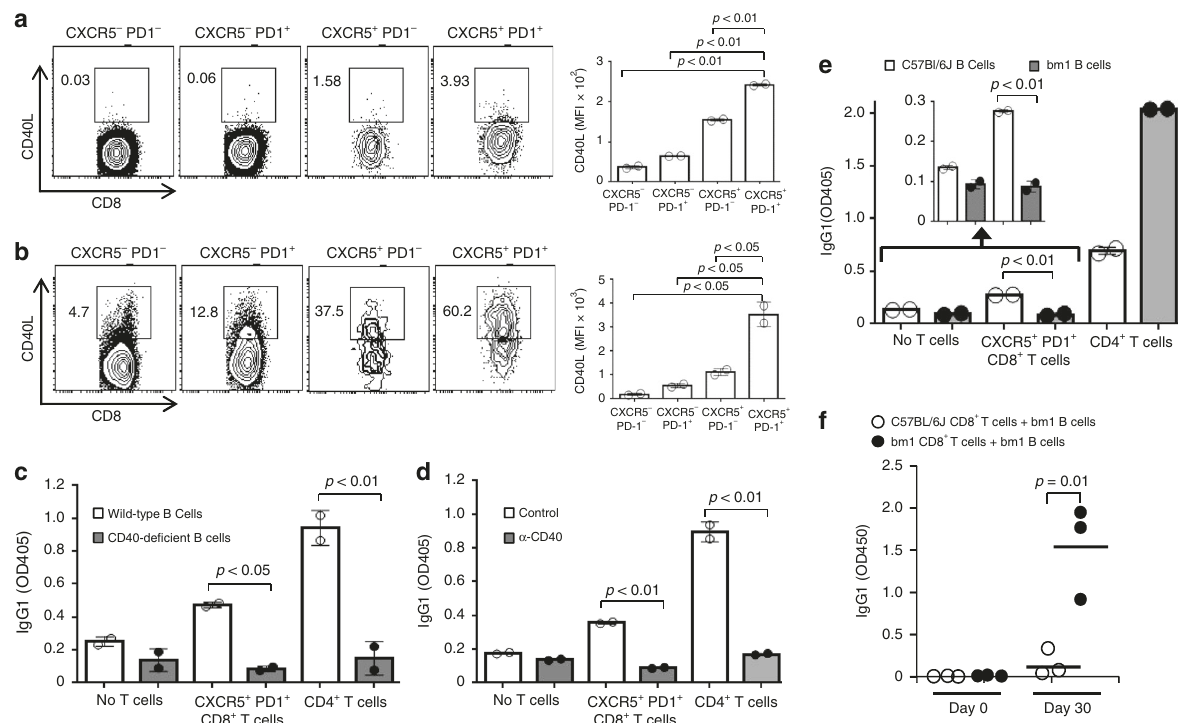
Fig. 7 CD40L/CD40 and TCR/MHC I interactions required for CD8 + Tfh function. a CD40L expression in CXCR5 + PD-1 + CD8 + T cells. Splenocytes from LCMV-infected wild-type mice were stained with anti-CD4, anti-CD8, anti-CXCR5, anti-PD-1 and anti-CD40L antibodies. Numbers indicate percentages of CD40L + cells (left) and bar graphs show the average MFI of CD40L expression in the indicated CD8 + populations (right). b CD40L expression in CXCR5 + PD-1 + CD8 + T cells following activation. Splenocytes from LCMV-infected wild-type mice were stimulated with PMA/ionomycin and stained as in a . Numbers indicate percentages of CD40L + cells (left) and bar graphs show the average MFI of CD40L expression in the indicated CD8 + populations (right). c , d Requirement of CD40/CD40L interaction for CXCR5 + PD-1 + CD8 + T cells to help B cells. B cells sorted from LCMV-infected wild-type or CD40-de fi cient mice were cultured without T cells or with CXCR5 + PD-1 + CD8 + or CD4 + T cells sorted from LCMV-infected wild-type mice ( c ). Wild-type B cells were cultured with CXCR5 + PD-1 + CD8 + or CD4 + T cells sorted from LCMV-infected wild-type mice with or without anti-CD40L neutralizing antibodies ( d ). Bar graphs show the IgG1 levels in the supernatant of the indicated co-cultures. e , f Requirement of TCR/MHC I interaction for CXCR5 + PD- 1 + CD8 + T cells to help B cells. B cells sorted from LCMV-infected C57BL/6J or bm1 mice were cultured without T cells or with CXCR5 + PD-1 + CD8 + or CD4 + T cells sorted from LCMV-infected C57BL/6J mice and the inset shows the zoomed area ( e ). Bar graphs show the IgG1 levels in the supernatant of the indicated co-cultures. CD8 + T cells sorted from LCMV-infected wild-type C57BL/6J or bm1 mice were adoptively transferred into Rag1-de fi cient mice along with B cells from LCMV-infected bm1 mice ( f ). The recipients were infected with LCMV and IgG production was measured 30 days later. Dot plots show the IgG1 levels in the sera of recipients adoptively transferred with the indicated cells. Bars represent the mean values and each dot represents an individual data value ( a – e ) or recipient ( f ) and horizontal bars indicate mean values. Mean ± SD is shown. P -values were calculated with the unpaired two- tailed Student ’ s t -test. Data shown are representative of two ( a – f ) independent experiments. Source data are available as a source data fi fi rst subset of CXCR5-expressing CD8 + T cells are exhausted